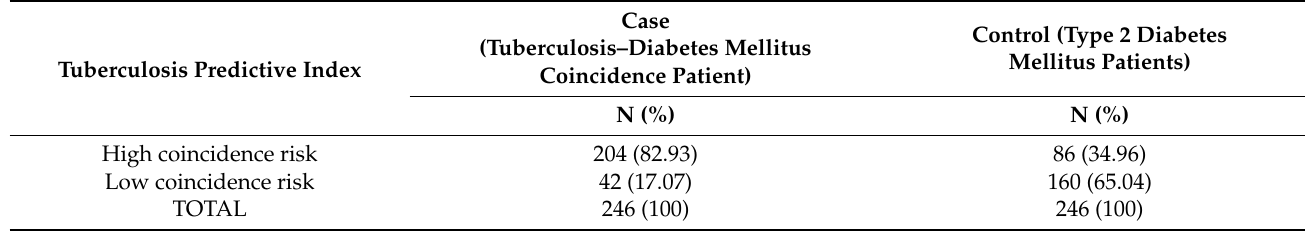
Table 4. Sensitivity and specificity of tuberculosis predictive index in type 2 diabetes mellitus.